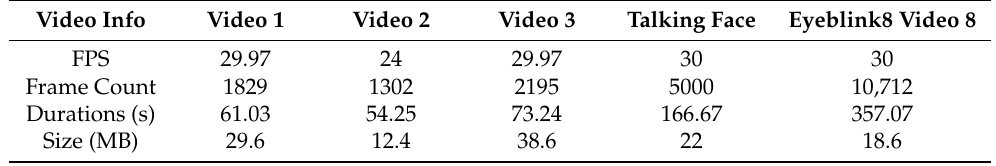
Table 1. Video dataset information.